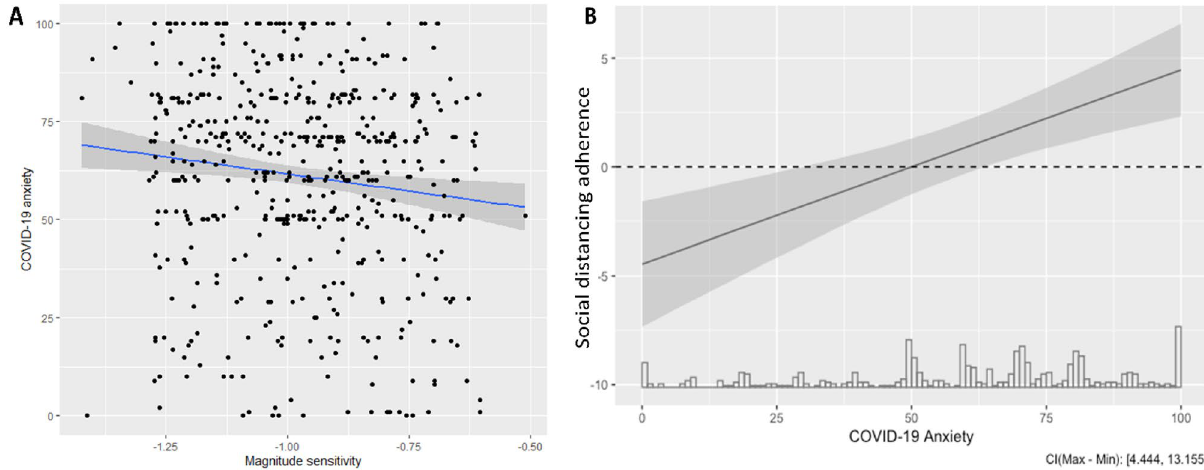
Figure 2. ( A ) Scatterplot indicating greater sensitivity to reward magnitude during delay discounting (i.e., lower values on the x-axis) predicted higher levels of specific COVID-19 anxiety. The regression line is